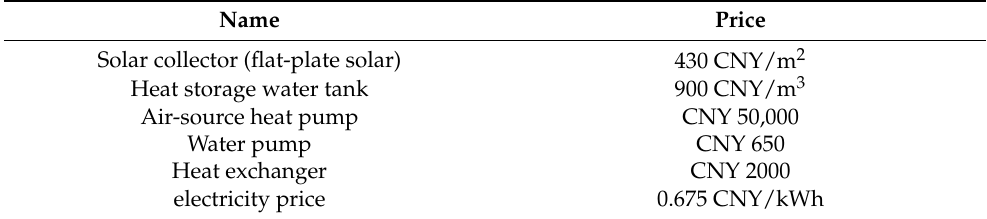
Table 3. Estimation of initial investment and operation costs of the system